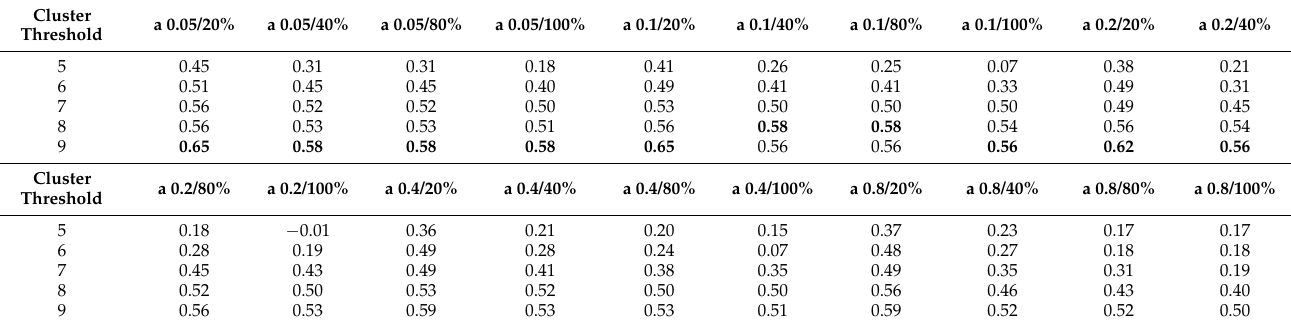
Table 1. Correlation matrix of Negribreen with each pixel and no buffer extracted compared to Haga et al. [13]. The cluster threshold marks the number of anomalies within the moving window (of the size nine) at any position per time step. Bold numbers indicate the highest correlation coefficient for each